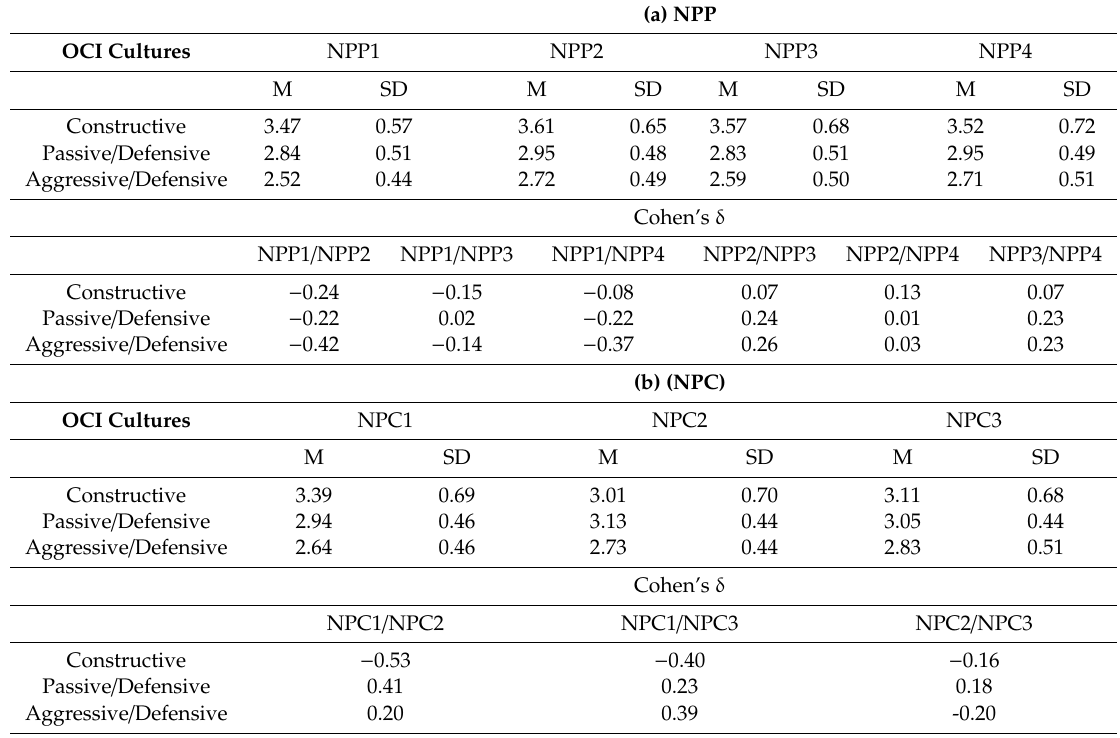
Table 6. OCI organizational cultures averages and e ff ect sizes for (a) nuclear power plants (NPP) and for (b) nuclear public companies